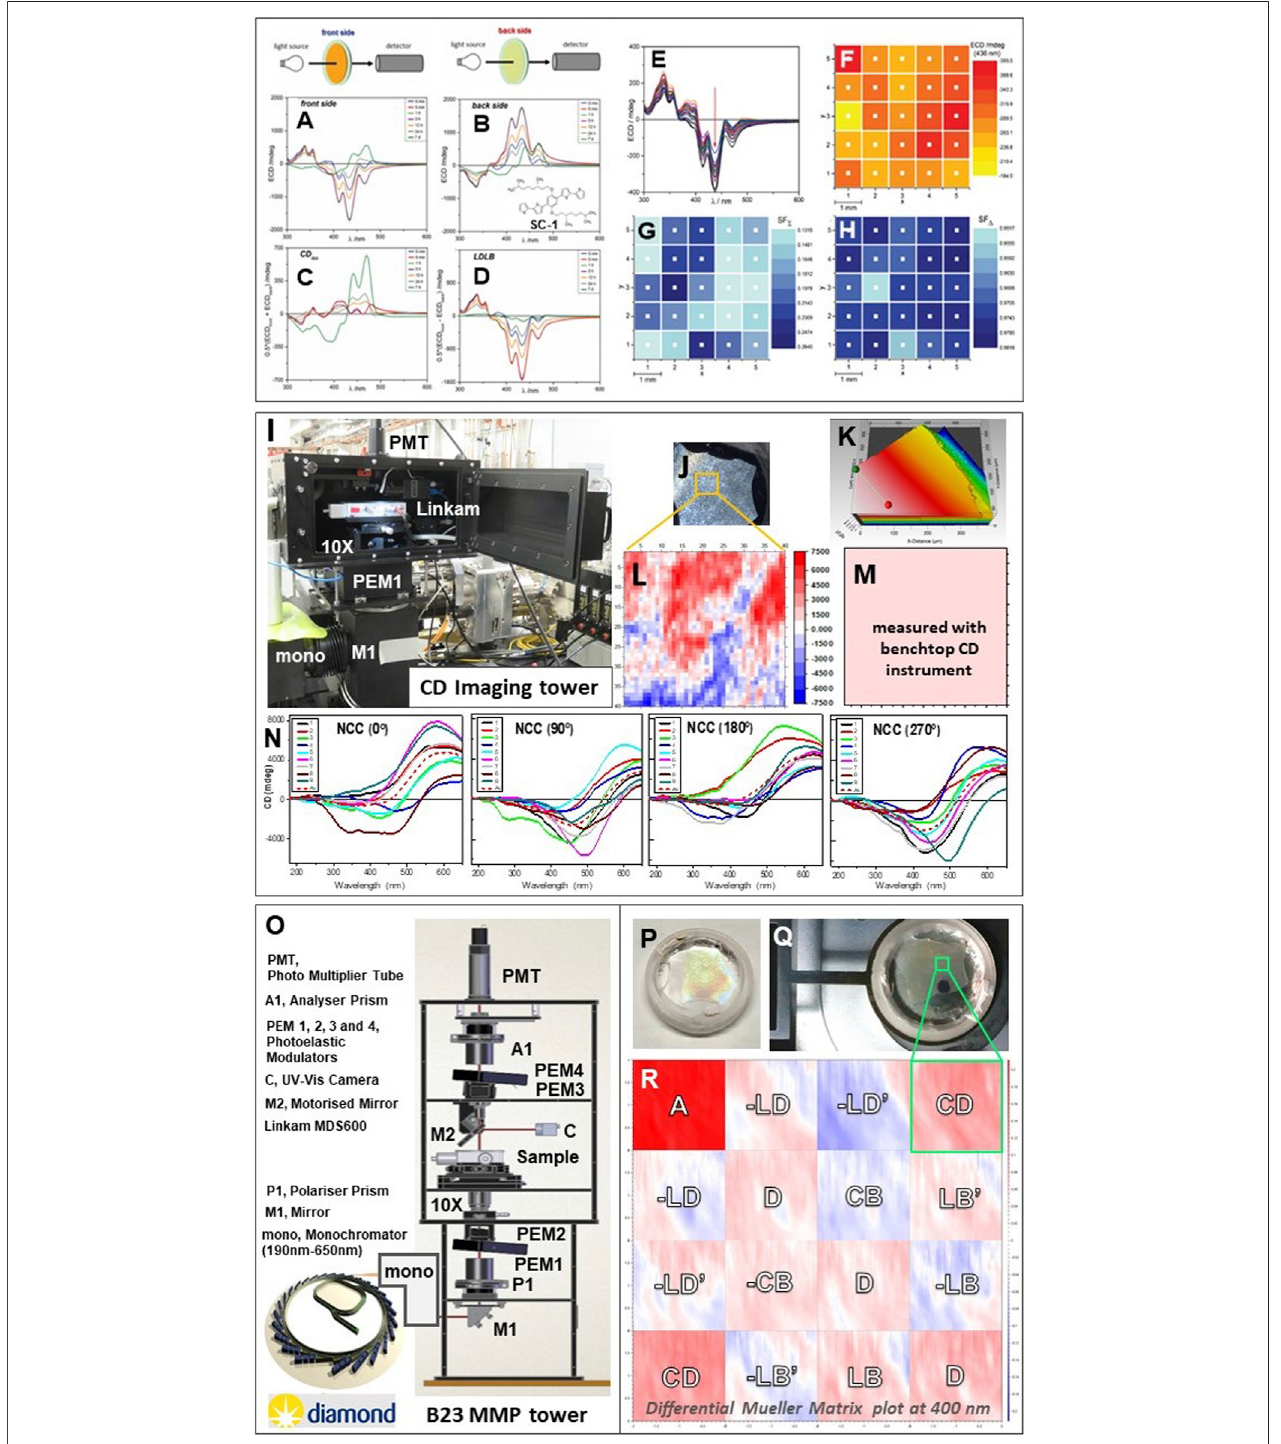
FIGURE 2 | (A) SRCD spectra of a thin fi lm of π -conjugated chiral molecule spin coated (SC-1) on a fused silica subtrate measured on the front side orientation as illustrated by the cartoon. (B) SRCD spectra of back side orientations. (C) Calculated SRCD spectra termed CD iso from the sum of spectra [(A + B)/2]. (D) Calculated SRCDspectratermedLDLBfromthedifferenceofspectra[(A – B)/2]. (E) 25CDspectraoffrontsideorientationmeasuredina5 × 5gridat1 mmintervals. (F) 2Dmapof SRCD intensities at 436 nm of the 5 × 5 grid measured in 2E. (G) Calculated 2D map of the CD ISO intensities at 436 nm of the same 5 × 5 grid illustrated in F (the back side orientation is not shown). (H) Calculated 2D map of LDLB intensities at 436 nm of the 5 × 5 grid. All fi gures redrawn from Albano et al. (2019). (I) CD imaging